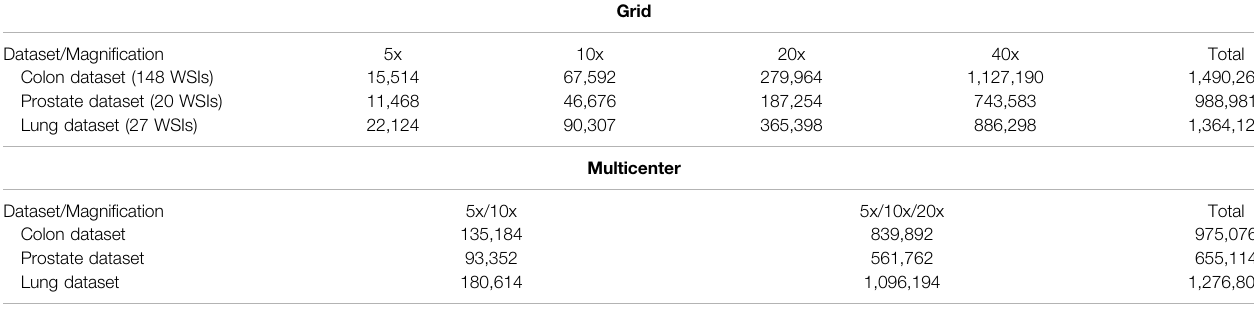
TABLE 1 | Number of patches extracted with the grid extraction method (above) and with the multi-center method (below), at different magni fi cation level.